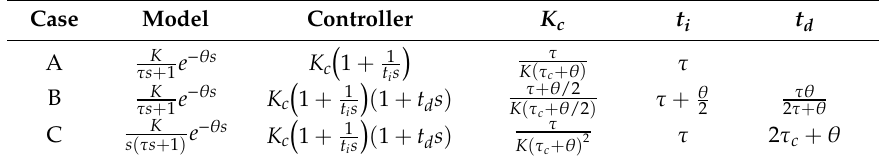
Table 1. Internal model-control (IMC)-based proportional-integral-derivative (PID) controller settings.